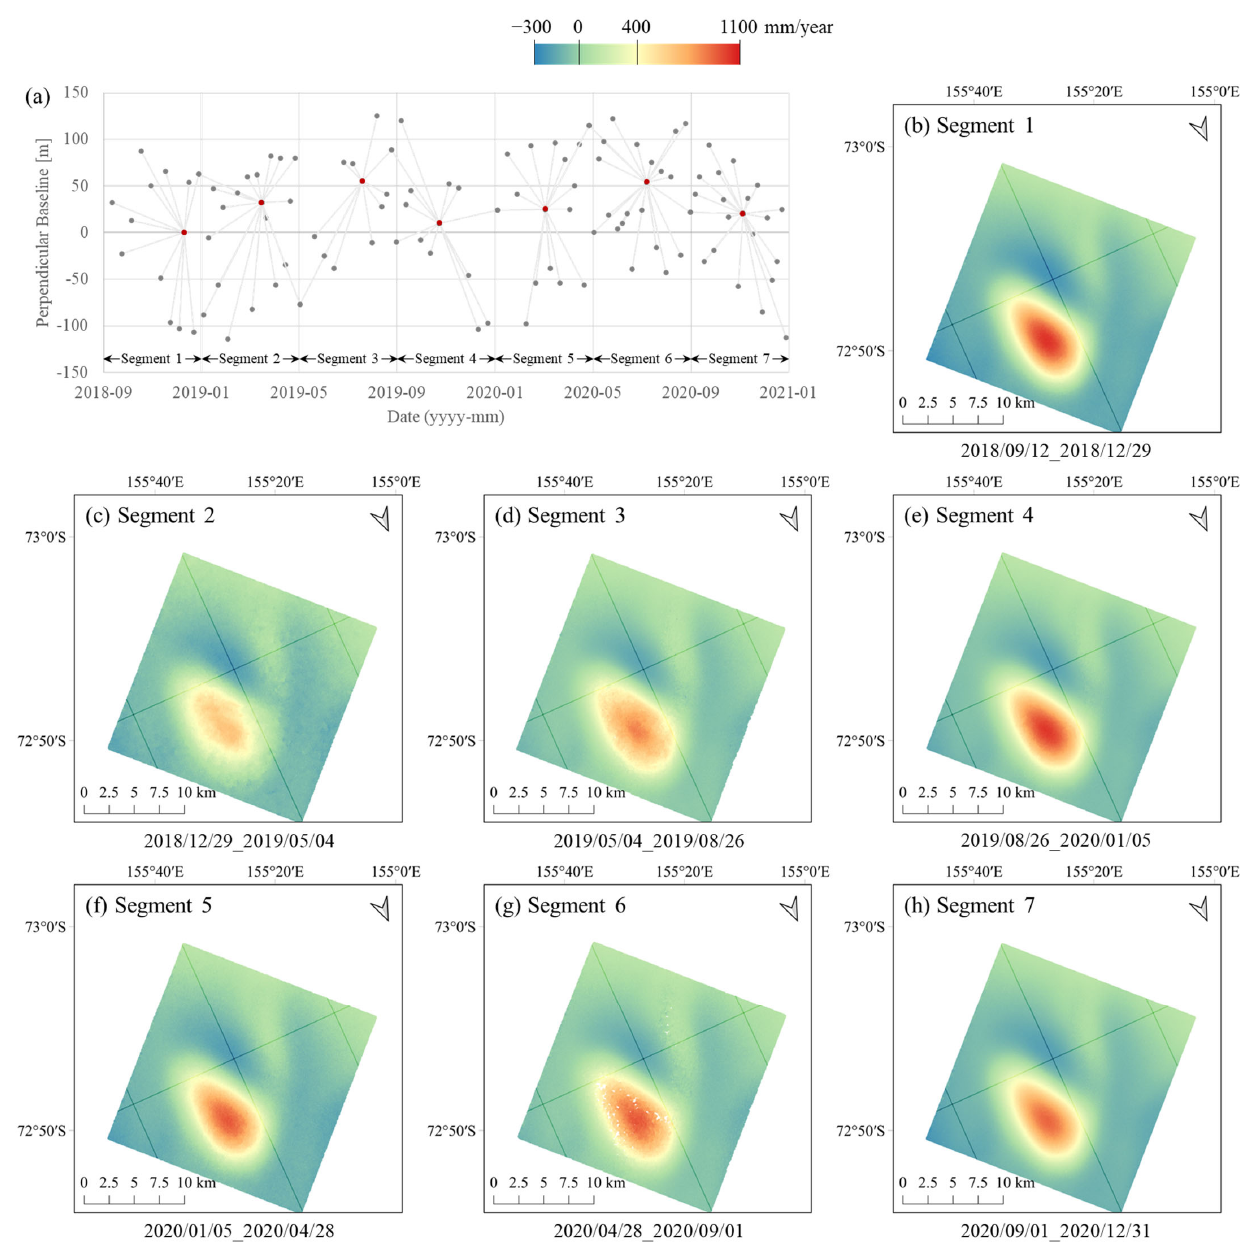
Figure 12. Mean LOS velocity maps using TS ‐ PSInSAR. ( a ) is a baseline plot of interferograms used in TS ‐ PSInSAR. The red dots are the master image of each segment while grey lines are linked to the slave images depicted as grey points. ( b – h ) are mean velocity maps for each segment.